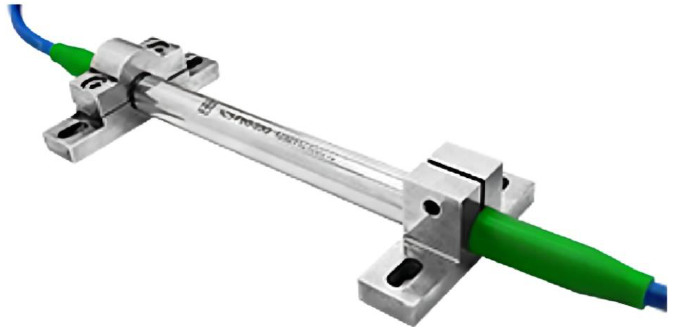
Table 1. Main parameters of the FBG strain sensor.